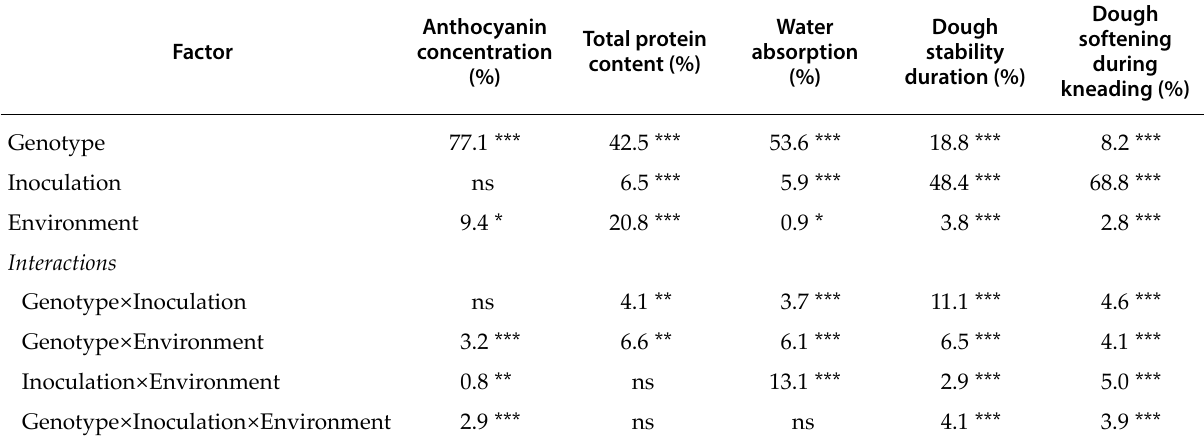
Table 5. Composition of the variances (%) between the different factors (genotype, inoculation, site/environment and interactions) affecting the parameters: anthocyanin concentration and protein content, water absorption, dough stability and dough softening during kneading. Significance levels: *** at P <0.001, **: at P <0.01, * at P <0.05, ns: Not significantly different ( P